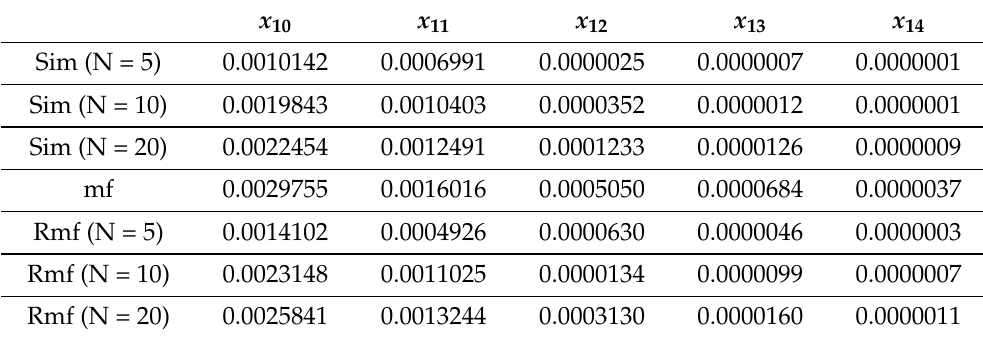
Table 4. Accuracy of mean-field approximation (mf) and refined mean-field approximation (rmf) when N = 5, 10, 20 for x 10 , . . . , x 14